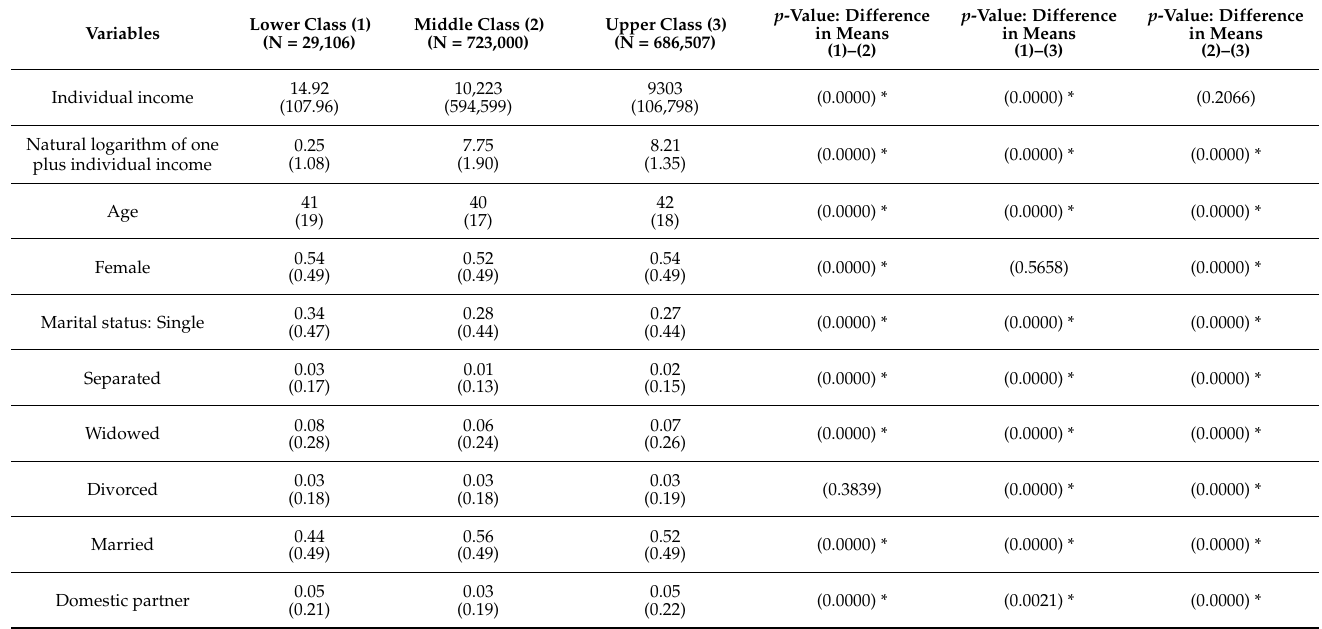
Table 1. Characteristics of individuals belonging to lower, middle and upper hypothesized income